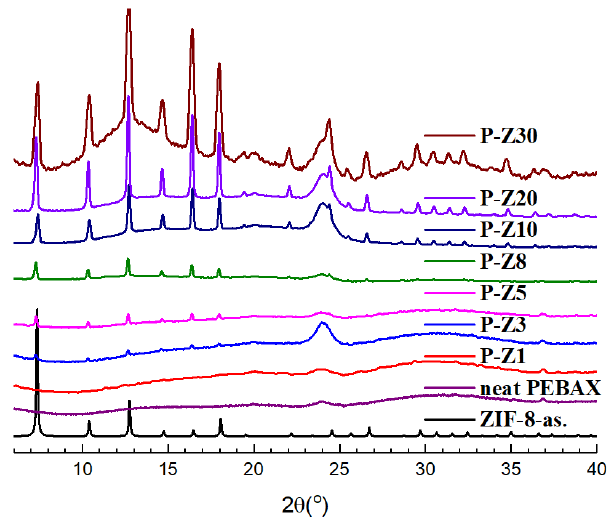
Figure 2. Powder pattern of Pebax/ n wt% ZIF-8 MMMs.